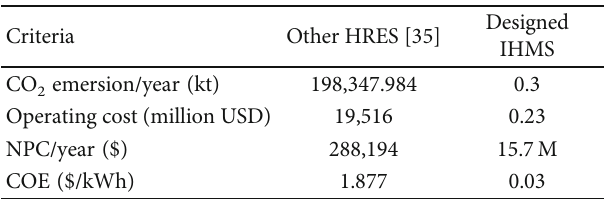
Figure 18: Active power response, frequency pro fi le, reactive power, and voltage magnitude from biogas generator module for four dispatch strategies. Table 2: Comparison of di ff erent criteria between the designed and other HRES [23].